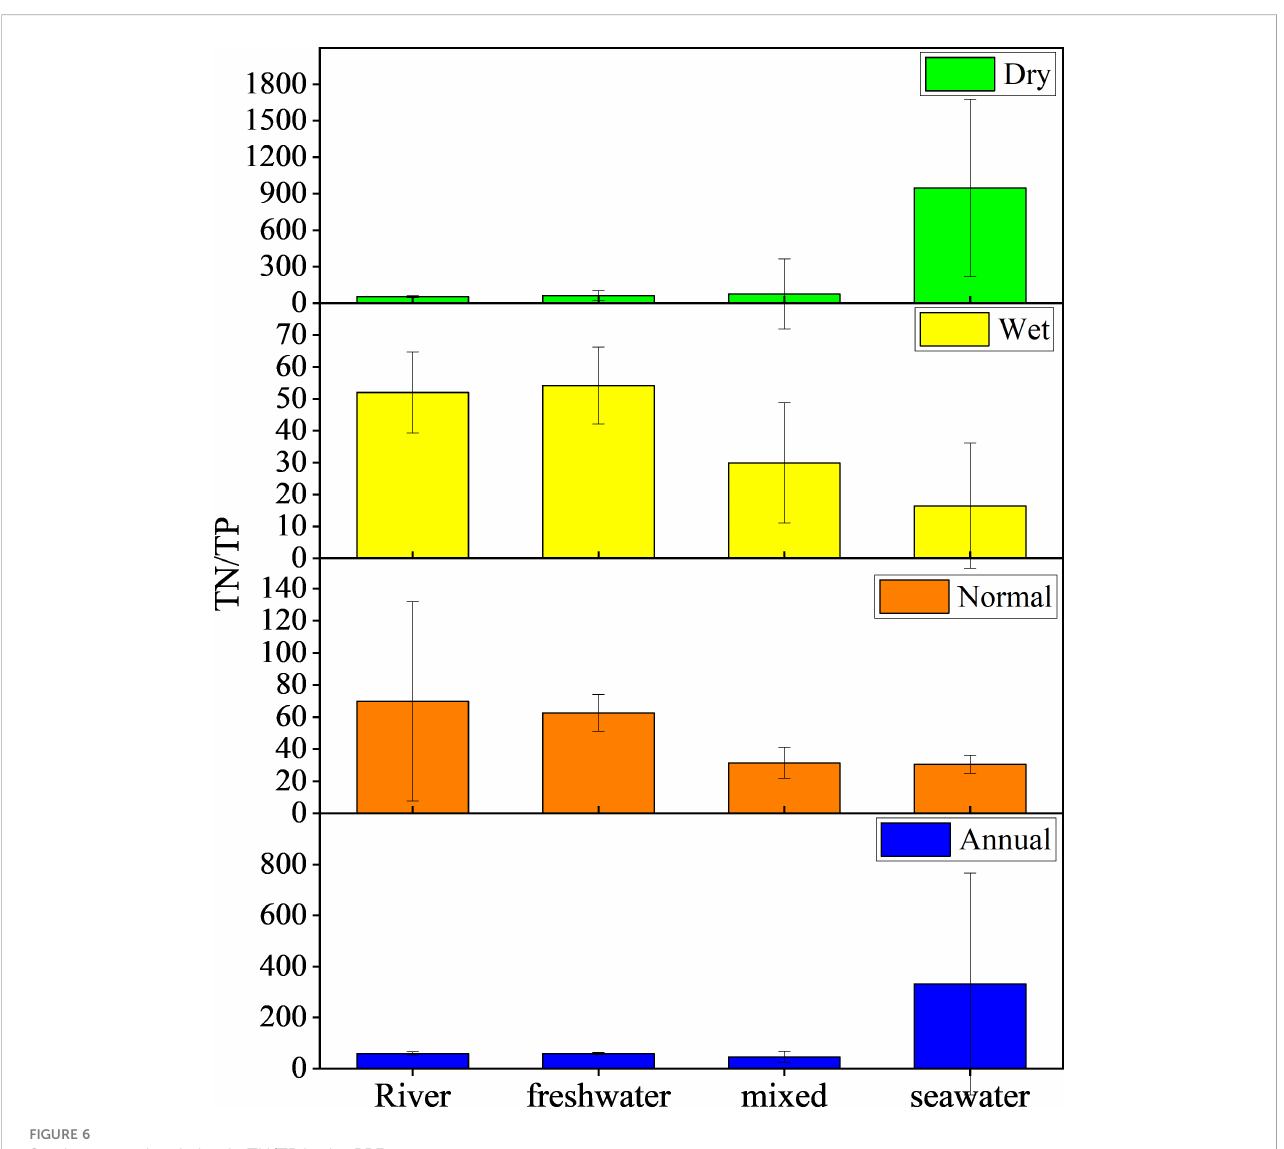
FIGURE 6 Spatiotemporal variation in TN/TP in the